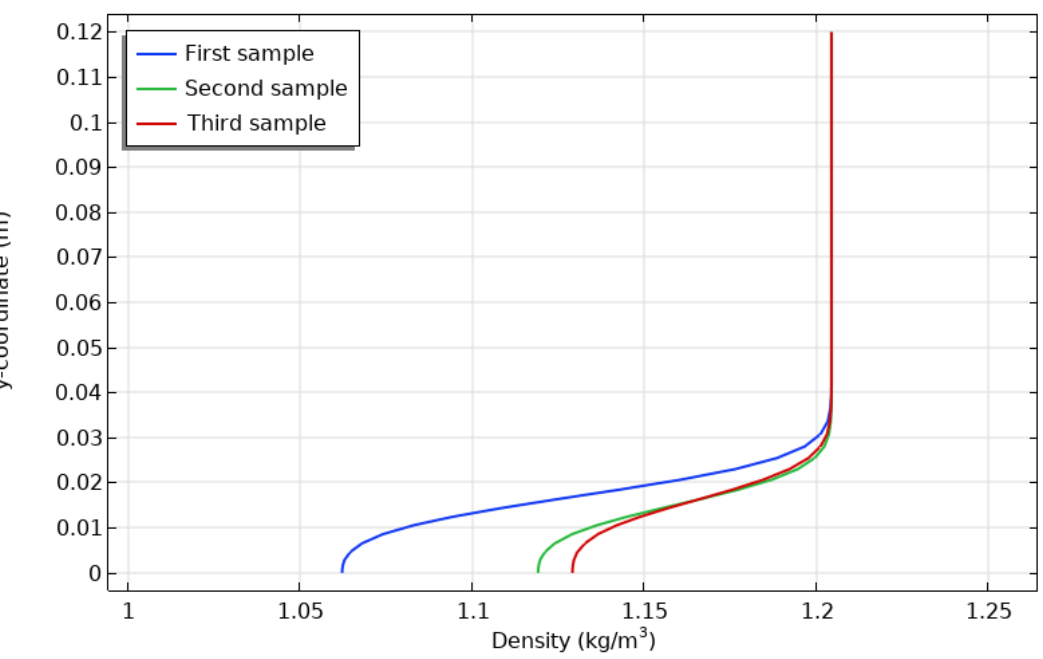
Figure 20. Density profile in the outlet passage flow .